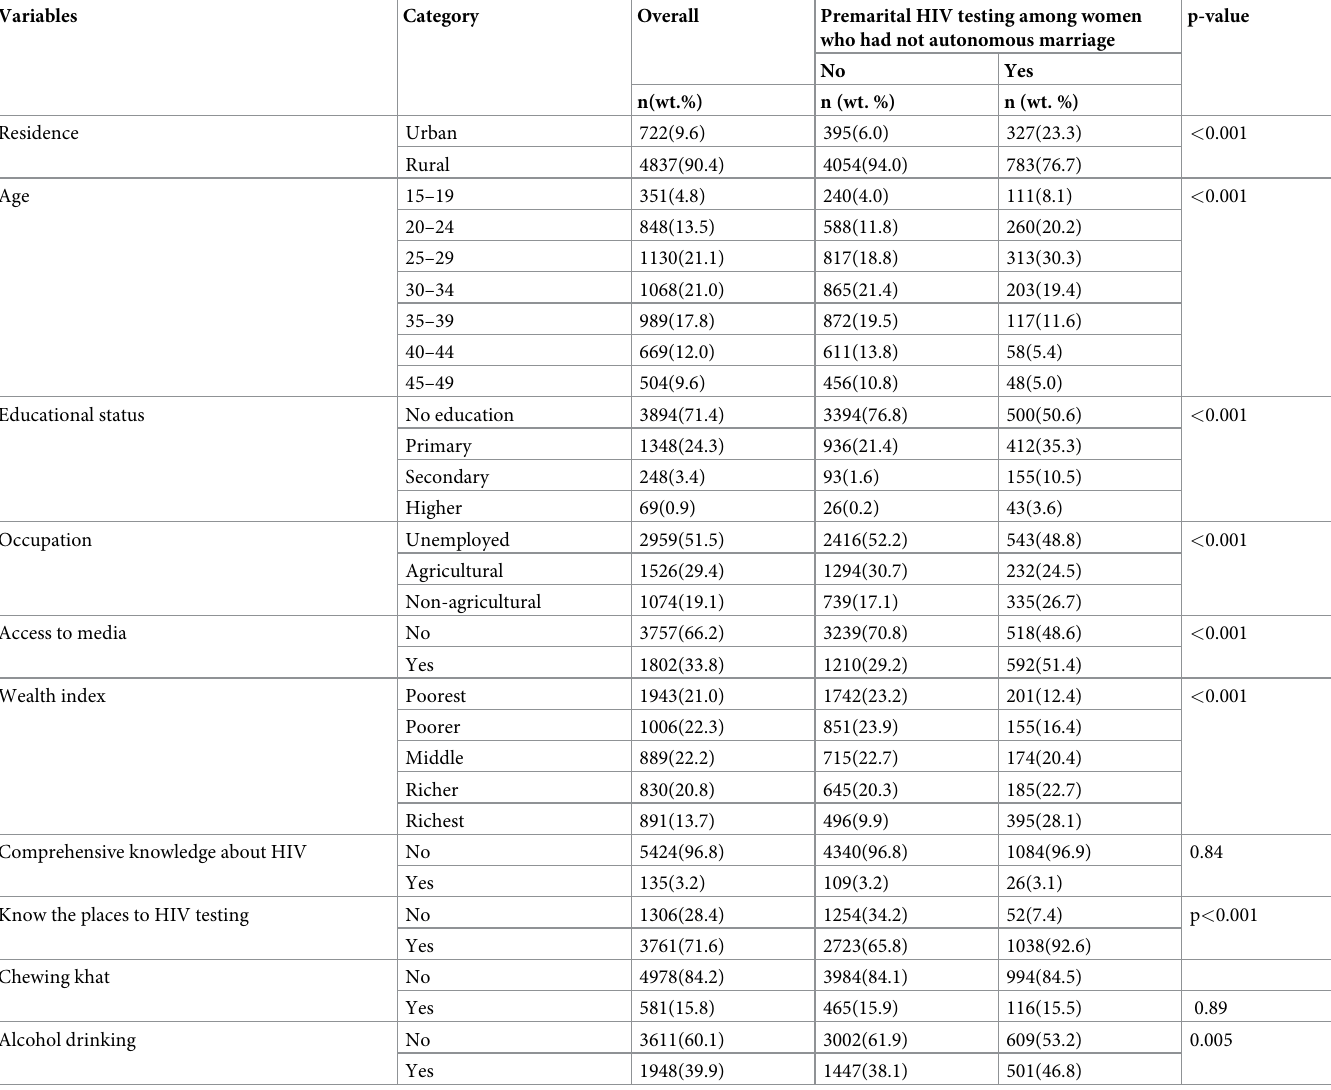
Table 2. Characteristics of the study participants who didn’t have autonomous marriage (n =